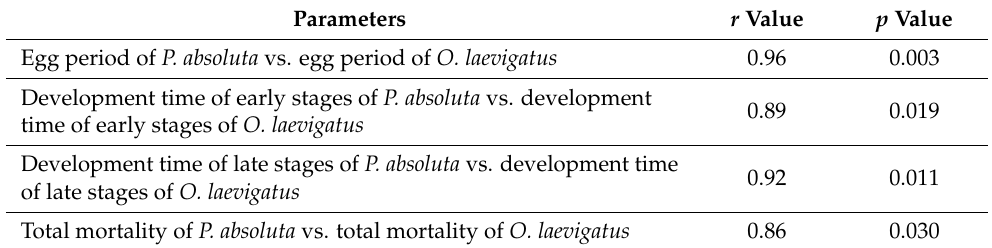
Table 2. Correlation between O. laevigatus and P. absoluta performance on six tomato genotypes. Parameters r Value p Value Egg period of P. absoluta vs. egg period of O. laevigatus 0.96 0.003 Development time of early stages of P. absoluta vs. development 0.89 0.019 time of early stages of O. laevigatus Development time of late stages of P. absoluta vs. development time 0.92 0.011 of late stages of O. laevigatus Total mortality of P. absoluta vs. total mortality of O. laevigatus 0.86